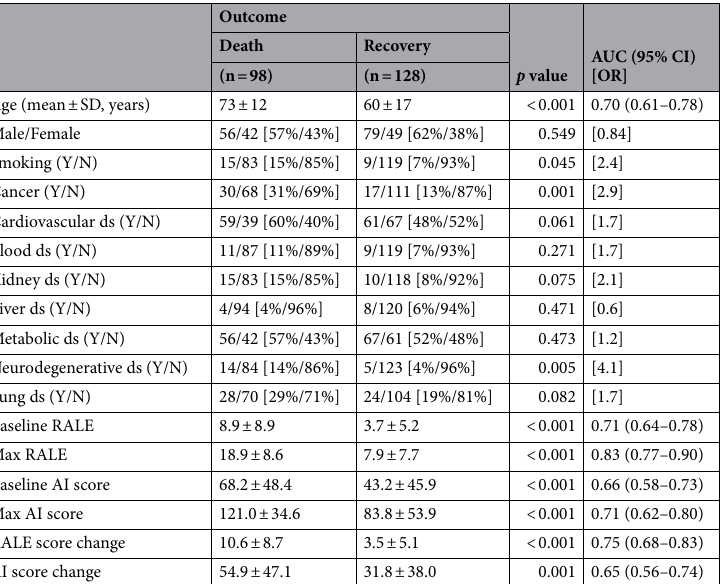
Table 1. Summary of assessed variables for prediction of death versus recovery from COVID-19 pneumonia in patients from Site A. Maximum RALE scores were stronger predictors than AI scores for final patient outcome. SD standard deviation, Y/N present or absent, ds disease, max maximum, AUC area under the curve, CI confidence interval, OR odd’s ratio, % percentage. Numbers in square parenthesis represent odd’s ratios (R2-14).